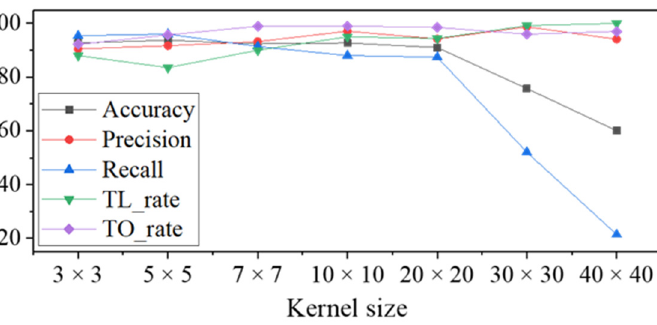
Figure 9. Graph depicting the defect inspection results according to the kernel size of 1st layer.